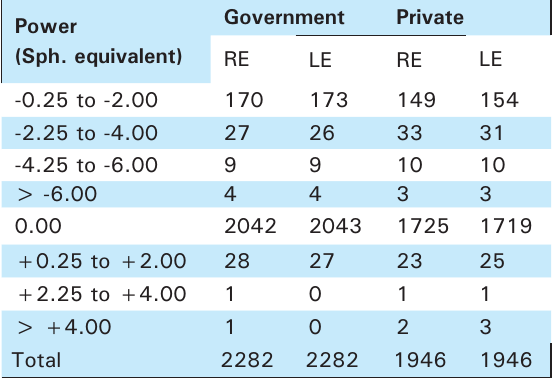
Table 4. Distribution of the refractive error